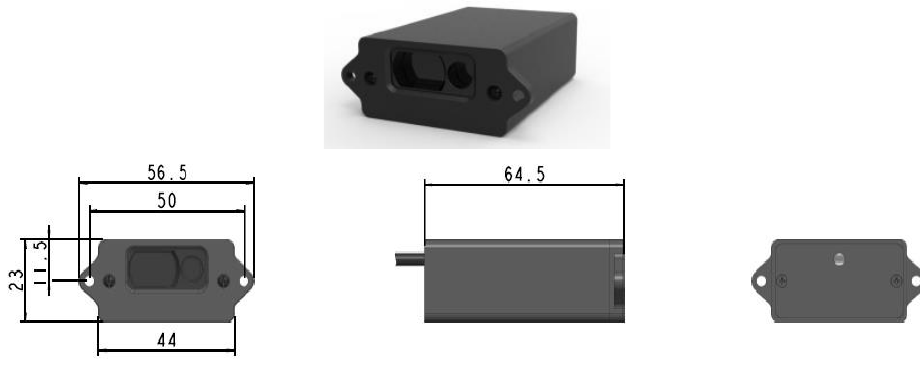
Figure 9. TF40 LiDAR. 2.2. Fast Scanning Image Using LiDAR